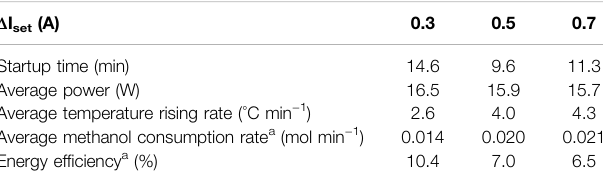
TABLE 1 | Parameters of DMFC startup at various Δ I set . C ini : 0.3 mol L − 1 , T ini : 23 ° C, and V set : 0.45 V cell − 1 . Δ I set